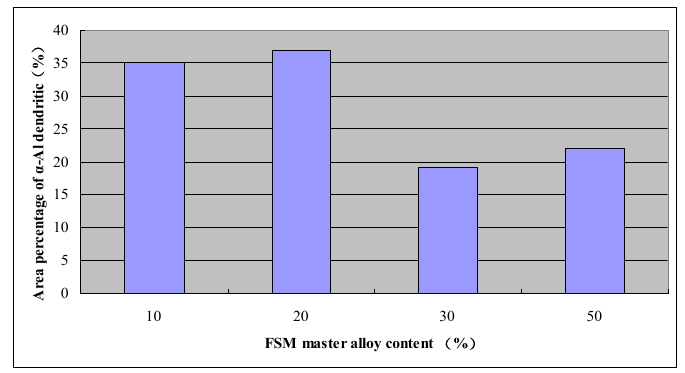
Figure 8. Effect of FSM master alloy content on the area percentage of α-Al dendrites.